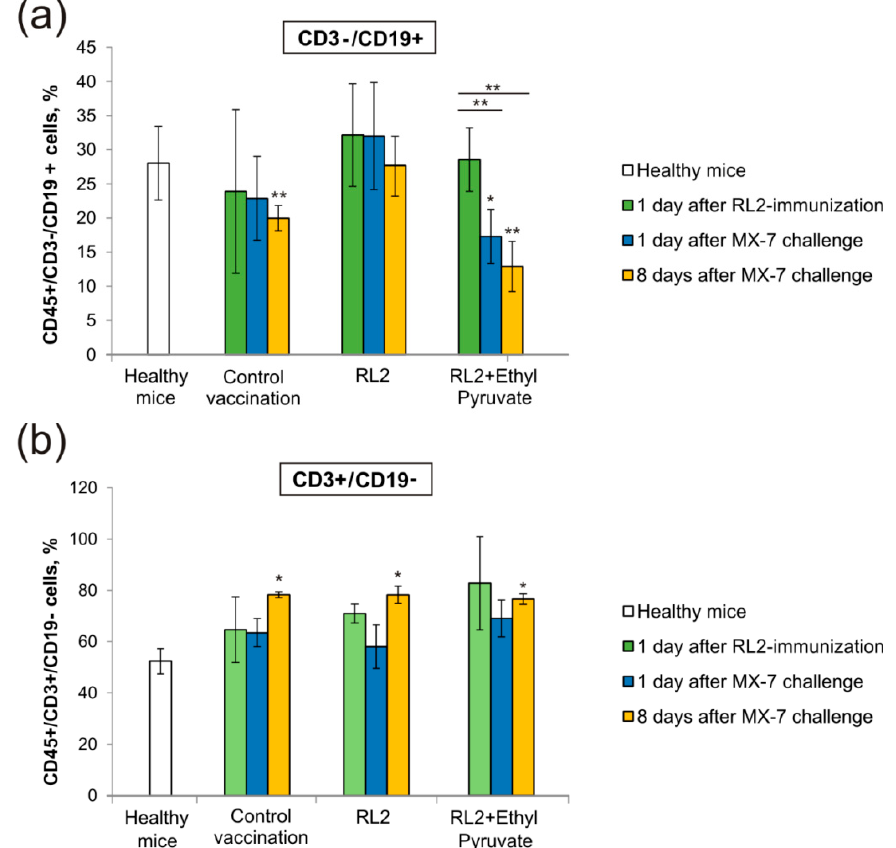
Figure 6. Distribution of immune cell populations in peripheral blood. PBMCs were harvested from whole blood samples, stained with CD45, CD3, and CD19 markers, and analyzed by flow cytometry. The number of positive cells is shown as a percentage of total blood CD45 + lymphocytes. ( a ) B-lymphocytes; ( b ) T-lymphocytes. Healthy mice were used as a negative control; “Control vaccination” mice were vaccinated with live MX-7 cells. Statistical differences between control and experimental groups are indicated by * for p < 0.05; ** for p < 0.01.